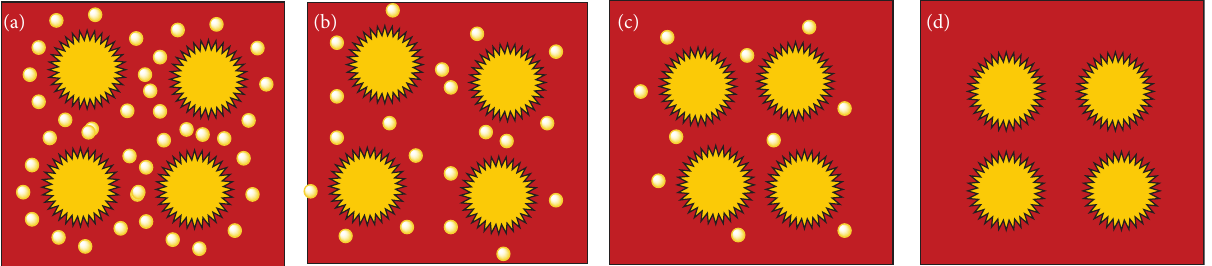
Scheme 2: Schematic view of an ideal distribution of gold atoms (yellow circles) in the reaction mixture: (a) Au-G6-10, (b) Au-G6-5, (c) Au-G6-2.5, (d) Au-G6-1.